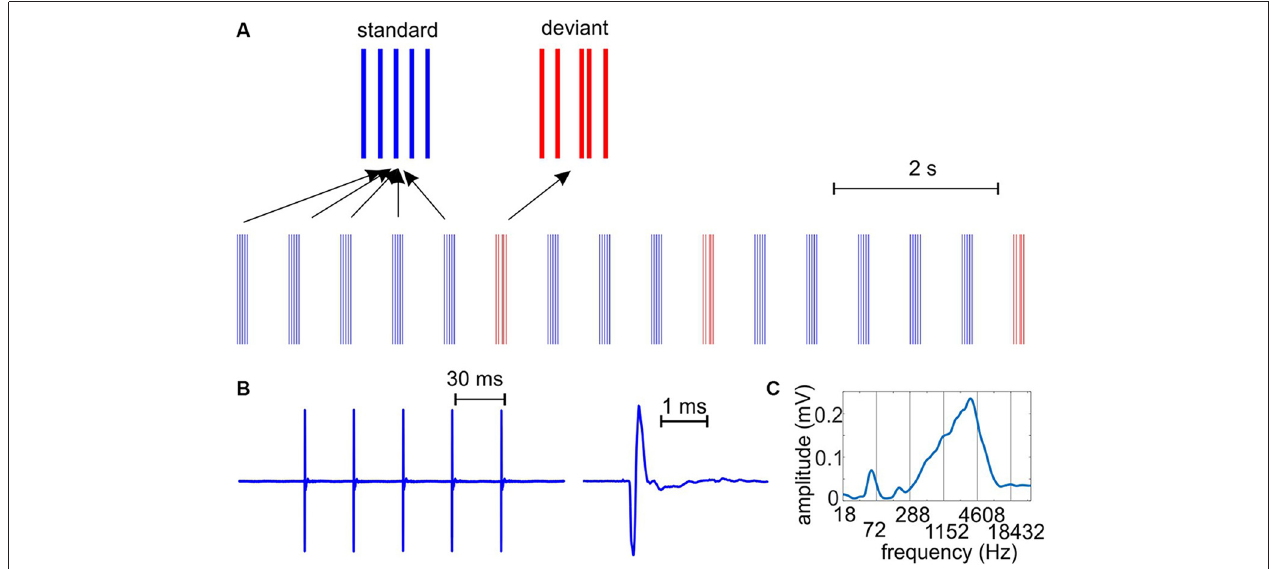
FIGURE 1 | The auditory stimulus stream. (A) We presented auditory clicks with a hierarchically organized rhythmic structure on two time-scales: trains of five clicks had a repetition rate of 33 Hz, while the click-trains occurred at a rate of 1.6 Hz. Deviant (target in the engaged condition) stimuli had a different temporal structure: the third click was shifted in time. Standard and deviant click trains presented were the same in passive and engaged conditions. (B) To the left, a standard click-train recorded with a microphone and digitized at 100 kHz. To the right, the waveform of an individual “click” as emitted by the speakers. The duration of the bipolar pulse is approximately 0.3 ms. (C) Spectrogram of the click train shows a prominent peak around 3.5 kHz, corresponding to the 0.3 ms “wavelength”, and smaller peaks at harmonics of the repetition